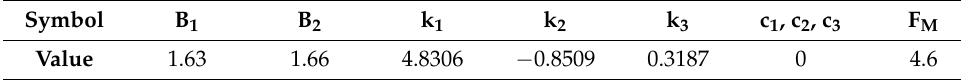
Table 3. The bare module cost constant factor of the heat